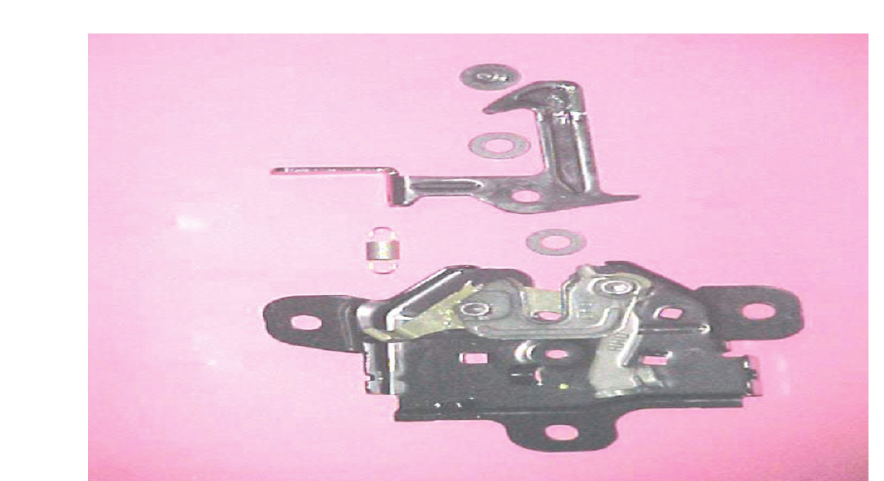
Fig. 4. SIPOC Diagram